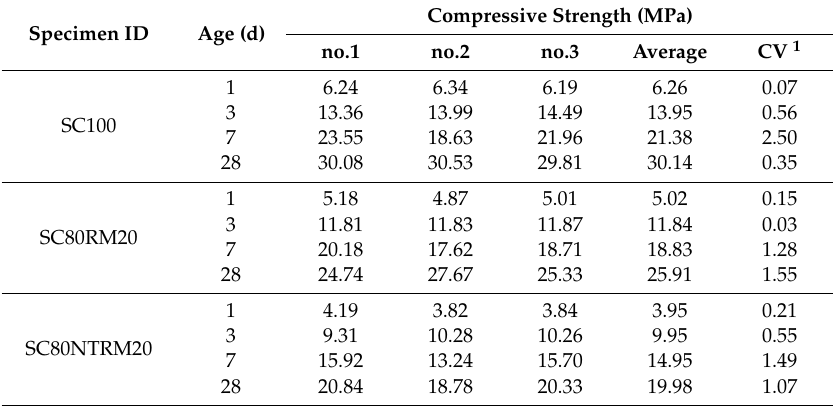
Table 5. Compressive strength data of different RM-type mortar specimens.